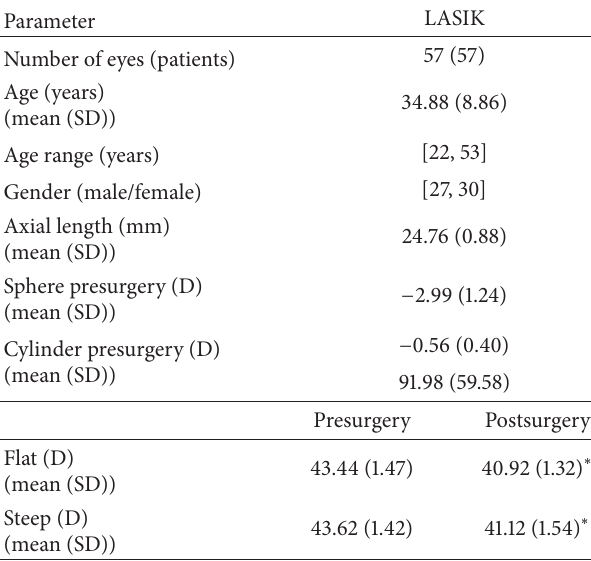
Table 1: Demographic characteristics of the participants in the